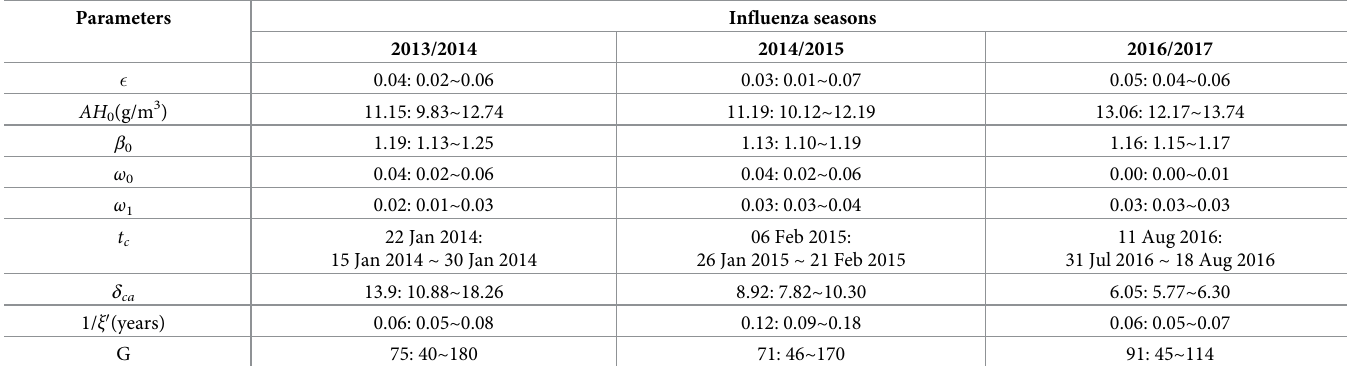
Table 1. Maximum likelihood estimations for the key parameters (mean: 95% CI). Parameters Influenza